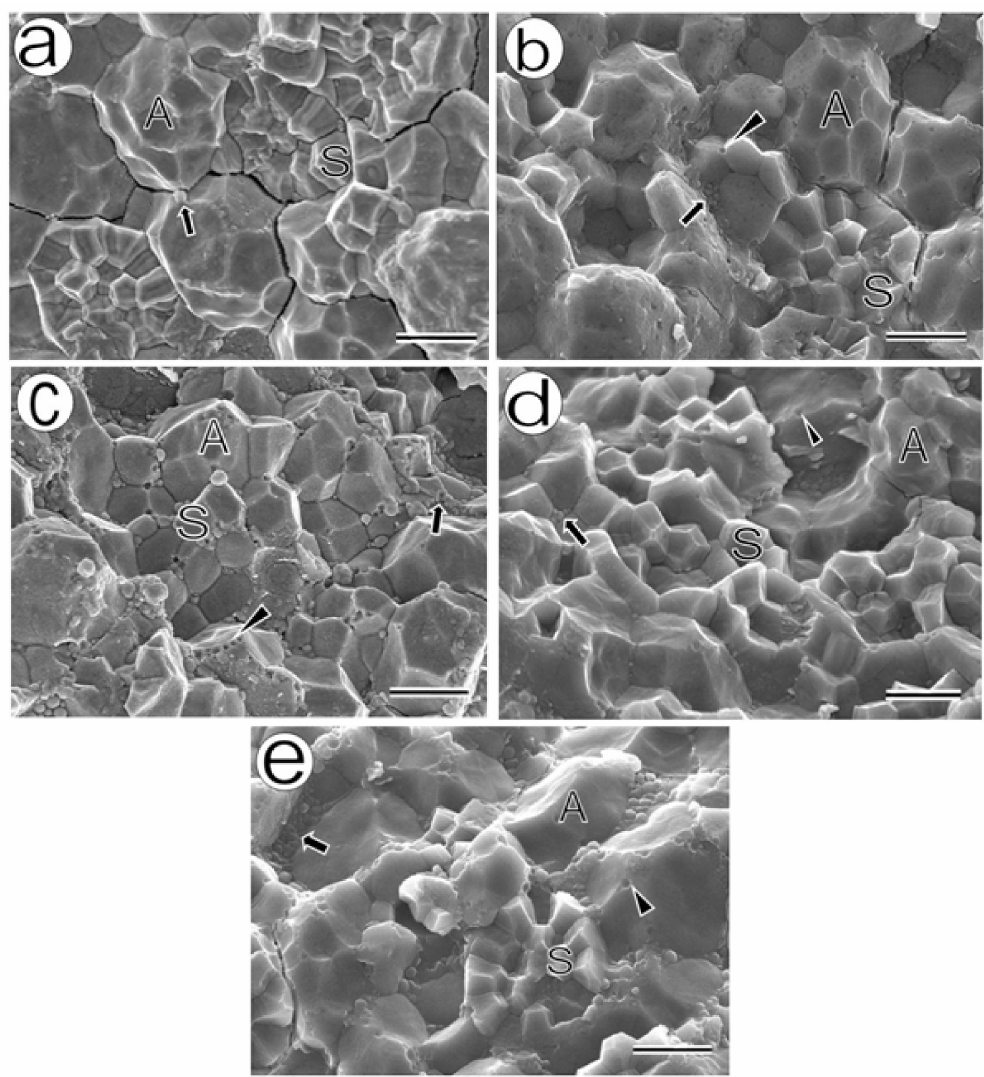
Figure 2. Accumulated structures and formation of rice grain in di ff erent treatments: A, amyloplast; S, starch granules; arrow, protein bodies; arrowhead, pits of protein particles. Bars: 10 µ m. ( a ) RD; ( b ) AM; ( c ) AMRD; ( d ) SD; ( e )